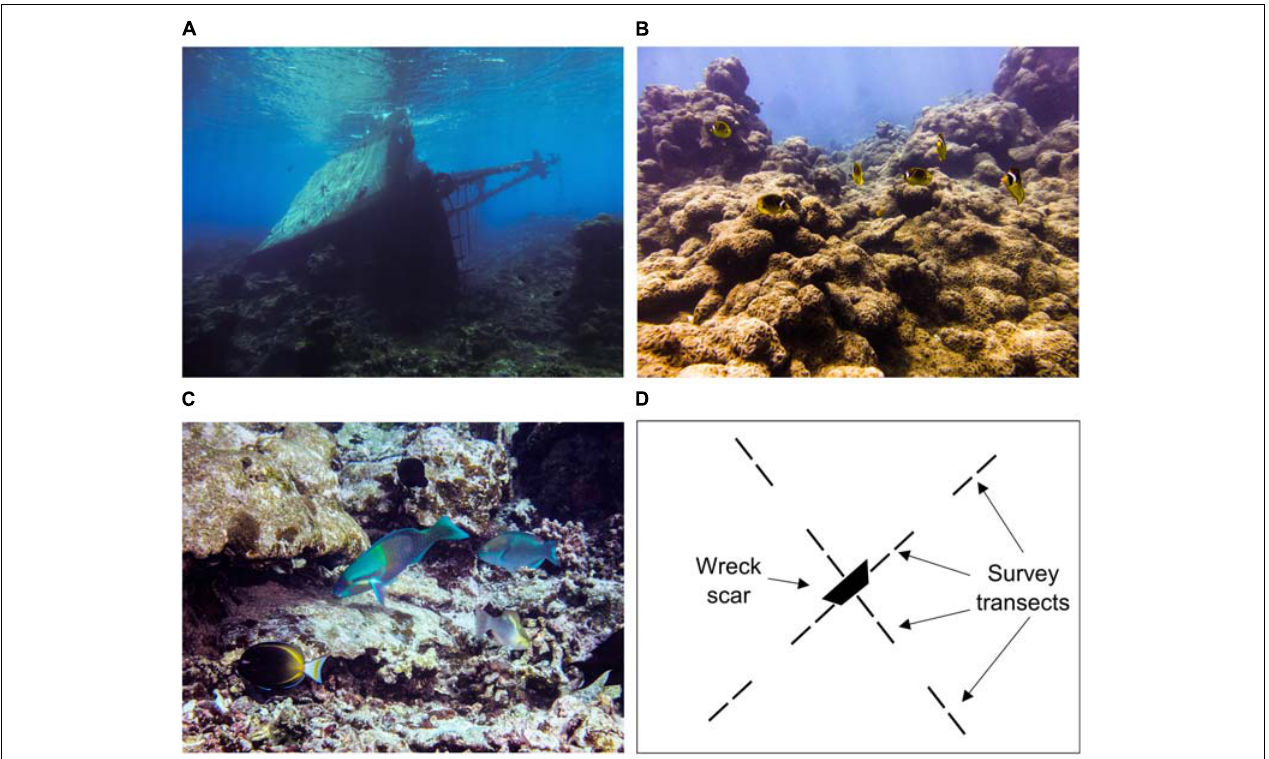
FIGURE 2 | (A) Image of the wreck in 2013 prior to removal, (B) image from the reef near the wreck in 2013 showing characteristically high (nearly 100%) cover of corallimorph, (C) image from the reef near the wreck site in 2017 showing mixed algal assemblage (CCA, turfing algae, macroalgae) with low corallimorph cover, and (D) diagram depicting transect layout at the wreck site (each transect is 25 m in length, outer transects originate 100 m from the center of the wreck